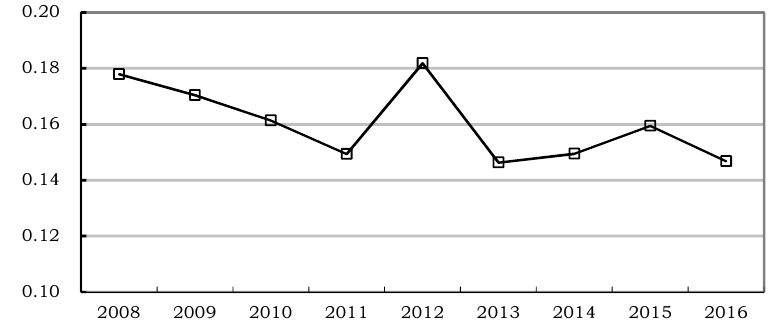
Figure 1. Theil index of the Chinese provincial community health service efficiency.